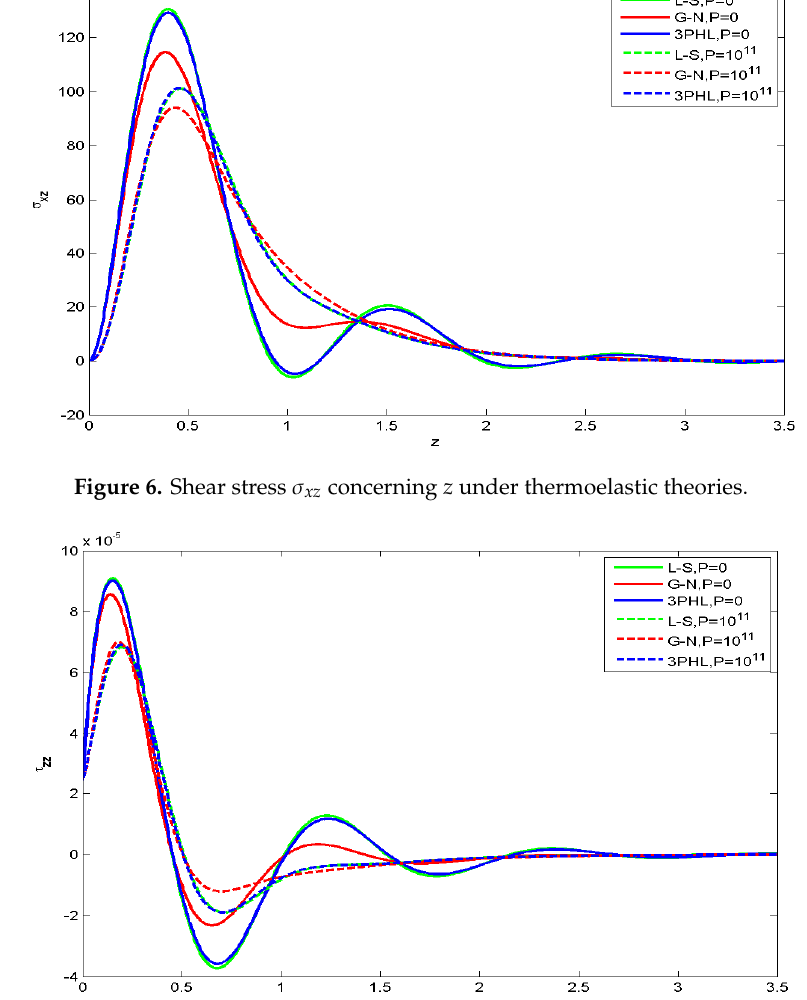
Figure 8. Total stresses zzzz στ + concerning z under thermoelastic theories.